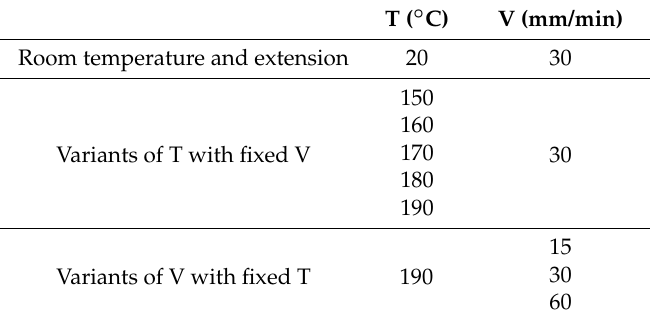
Figure 3. ( a ) Bias extension test set up of the tensile machine with the specimen and ( b ) Undeformed rectangular specimen and deformed shape of the specimen showing half shear and full shear zone. Table 3. The bias extension test